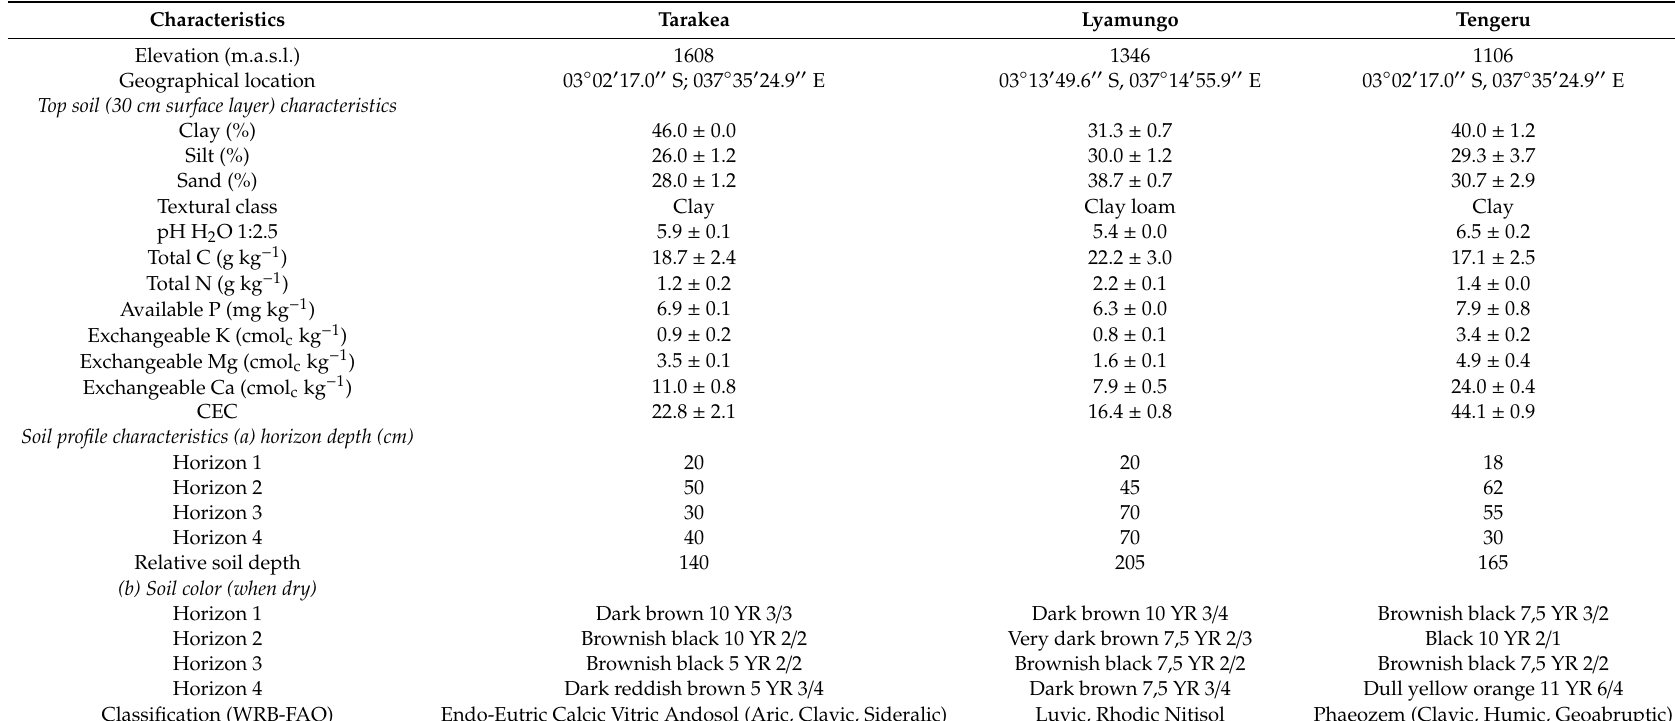
Table 1. Salient features of the experimental